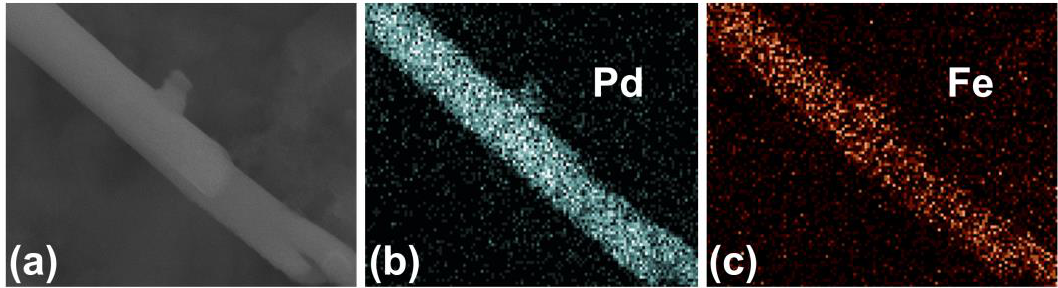
Figure 5. EDS maps of Porous-B NW ( a ) showing the presence and distribution of Pd ( b ) and Fe ( c ) throughout the length of the NW.